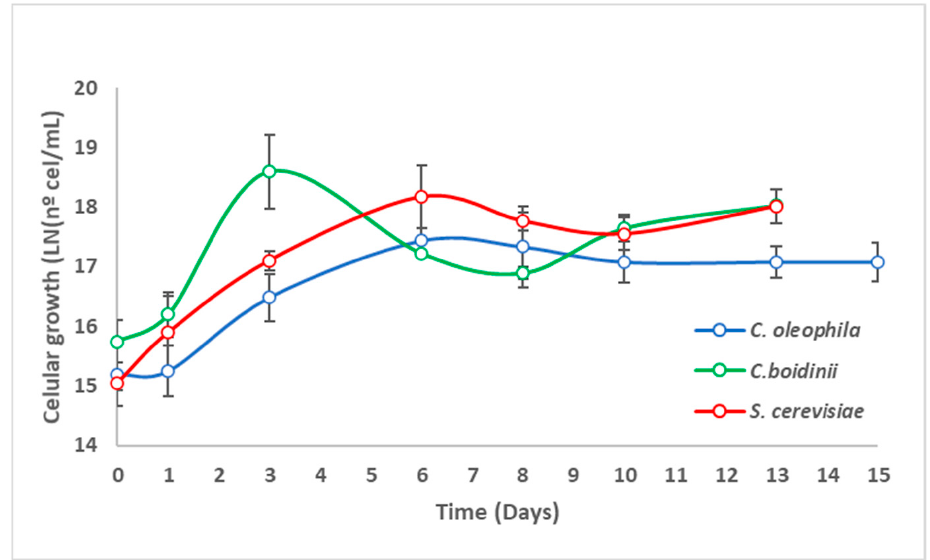
Figure 2. Evolution of cell proliferation in monoculture fermentations (Sauvignon Blanc).